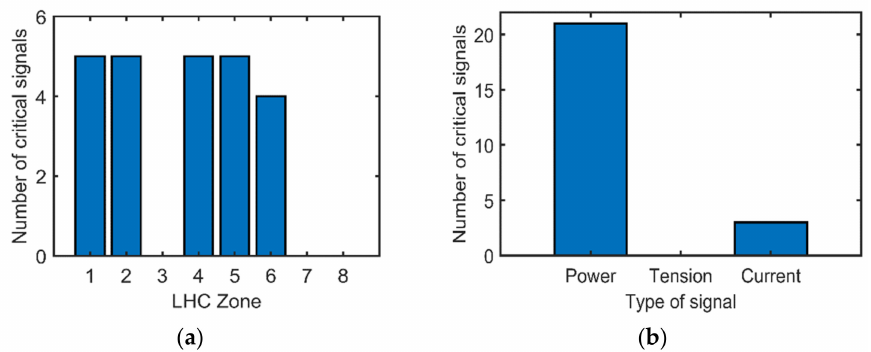
Figure 9. Location of the identified critical components ( a ) and type of selected signals ( b ).